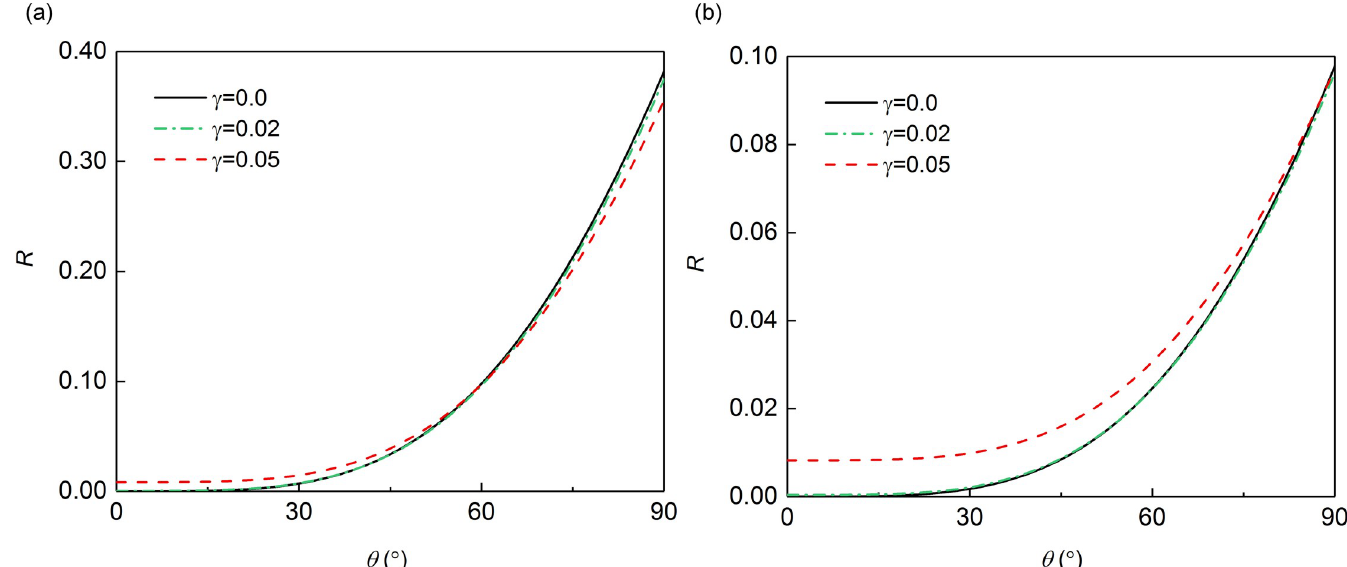
Fig 3. Reflection coefficient in case A : (a) Δ t / T = 1/10 ; (b) Δ t / T = 1/20 .